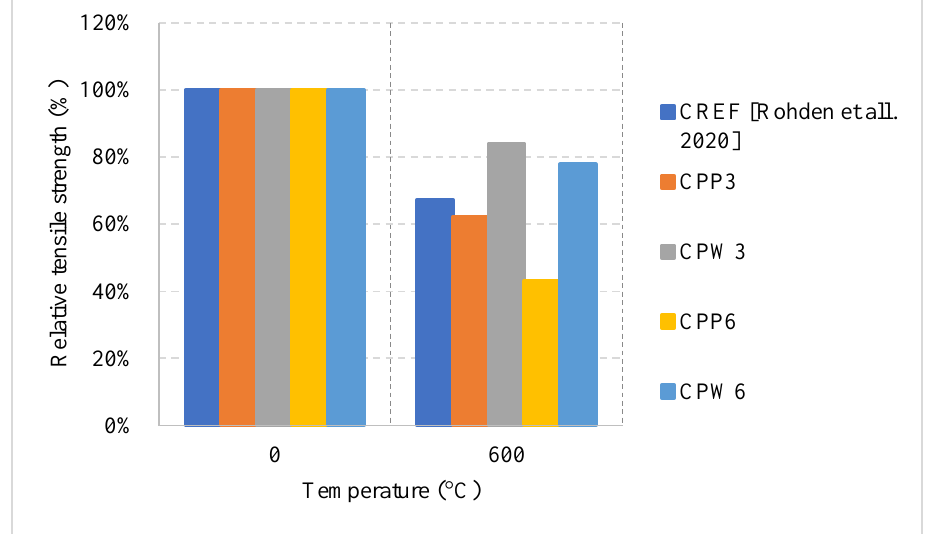
Figure 17. Relative tensile strength of naturally cooled HSC. CPP3: Concrete with 3 kg/m 3 Polypro- pylene fibers, CPP6: Concrete with 6 kg/m 3 Polypropylene fibers, CPW3: Concrete with 3 kg/m 3 Plastic Waste, CPW6: Concrete with 6 kg/m 3 Plastic Waste [77].